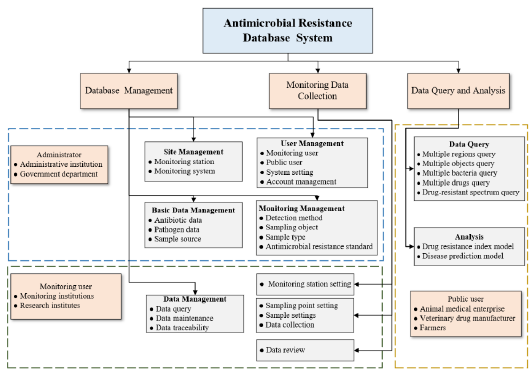
Figure 2. The overall design scheme of the system.